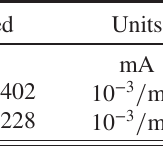
TABLE II. Measured mode 0 tune shifts and TMCI thresholds for Q 0 H ¼ Q 0 V ¼ 0 , the error on the tune shifts is estimated from the width of the spectrum, which was deformed during the measurements.